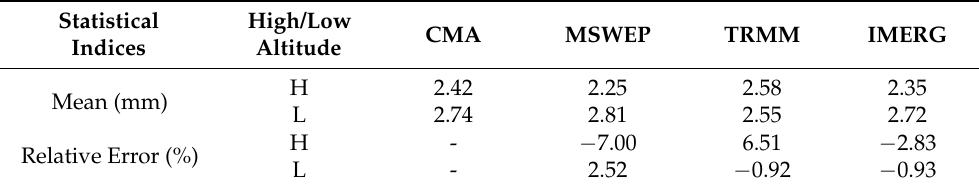
Table 5. Daily relative errors from three precipitation products against ground observation data and daily average precipitation at different elevation